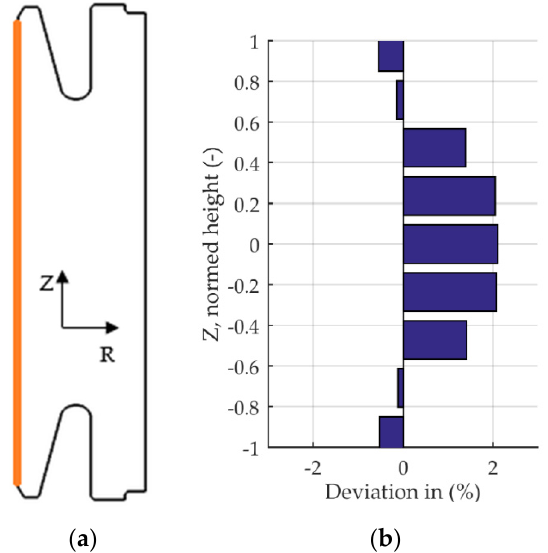
Figure 9. Percentage deviation of measured and simulated radial displacement at the bore at nine measurement positions. ( a ) Measurement location. ( b ) Percentage deviation of displacement.